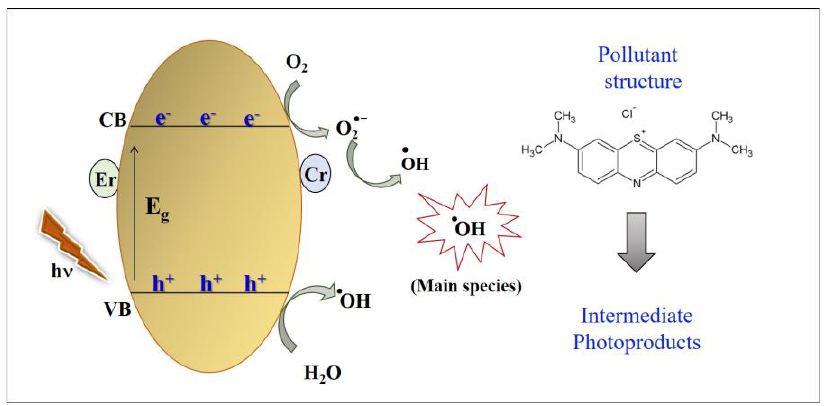
Figure 6. Photocatalytic mechanism of Zn 0.94 Er 0.02 Cr 0.04 O material.